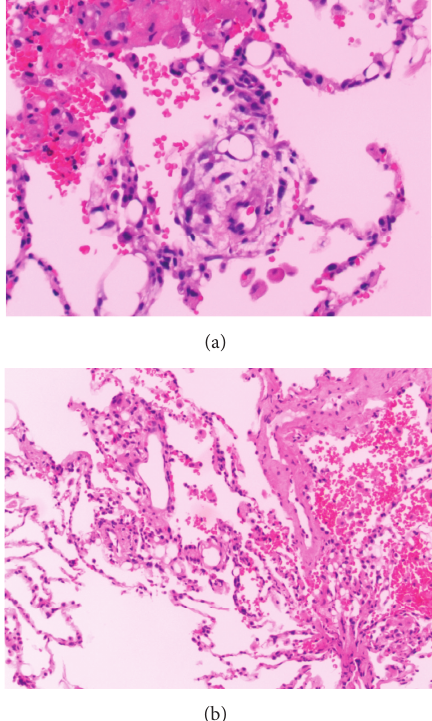
Figure 3: Pathologic specimens obtained during bronchoscopy from a 30-year-old female after illicit silicone injection to sub- cutaneous tissue. Findings: Silicone infiltration with subsequent spillage into alveolar spaces; exogenous lipoid pneumonia-type injury